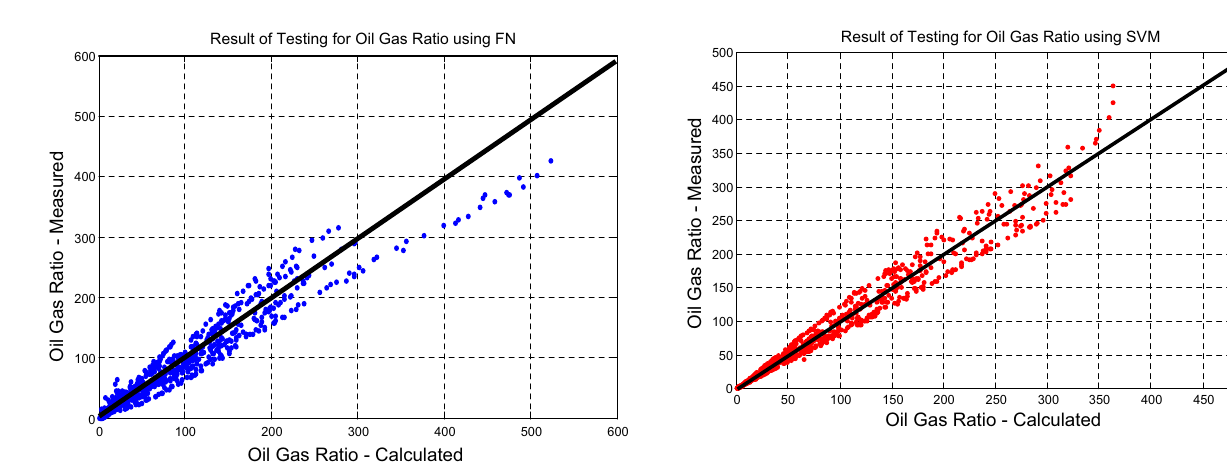
v using SVM for training